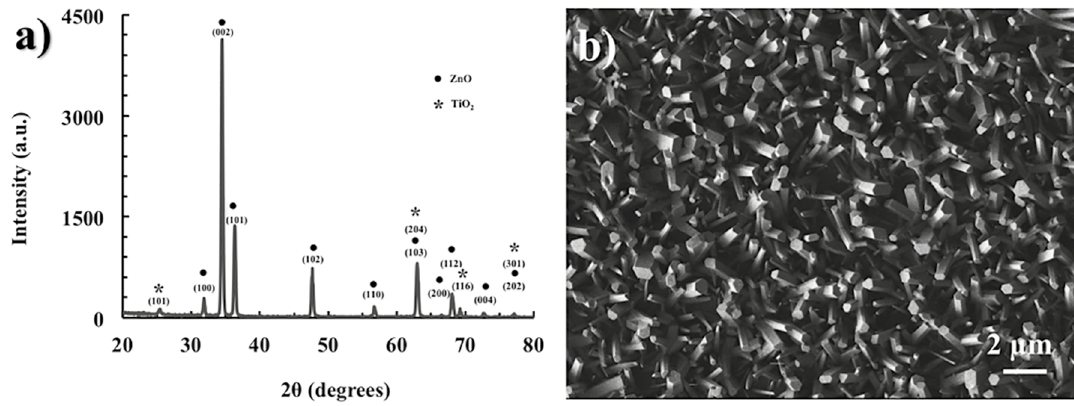
Figure 2. Total (R, T) and diffuse (R transmittance and reflectance spectra of sample Z in the UV- Vis region. Total components are mainly constituted by diffuse interactions in both cases.